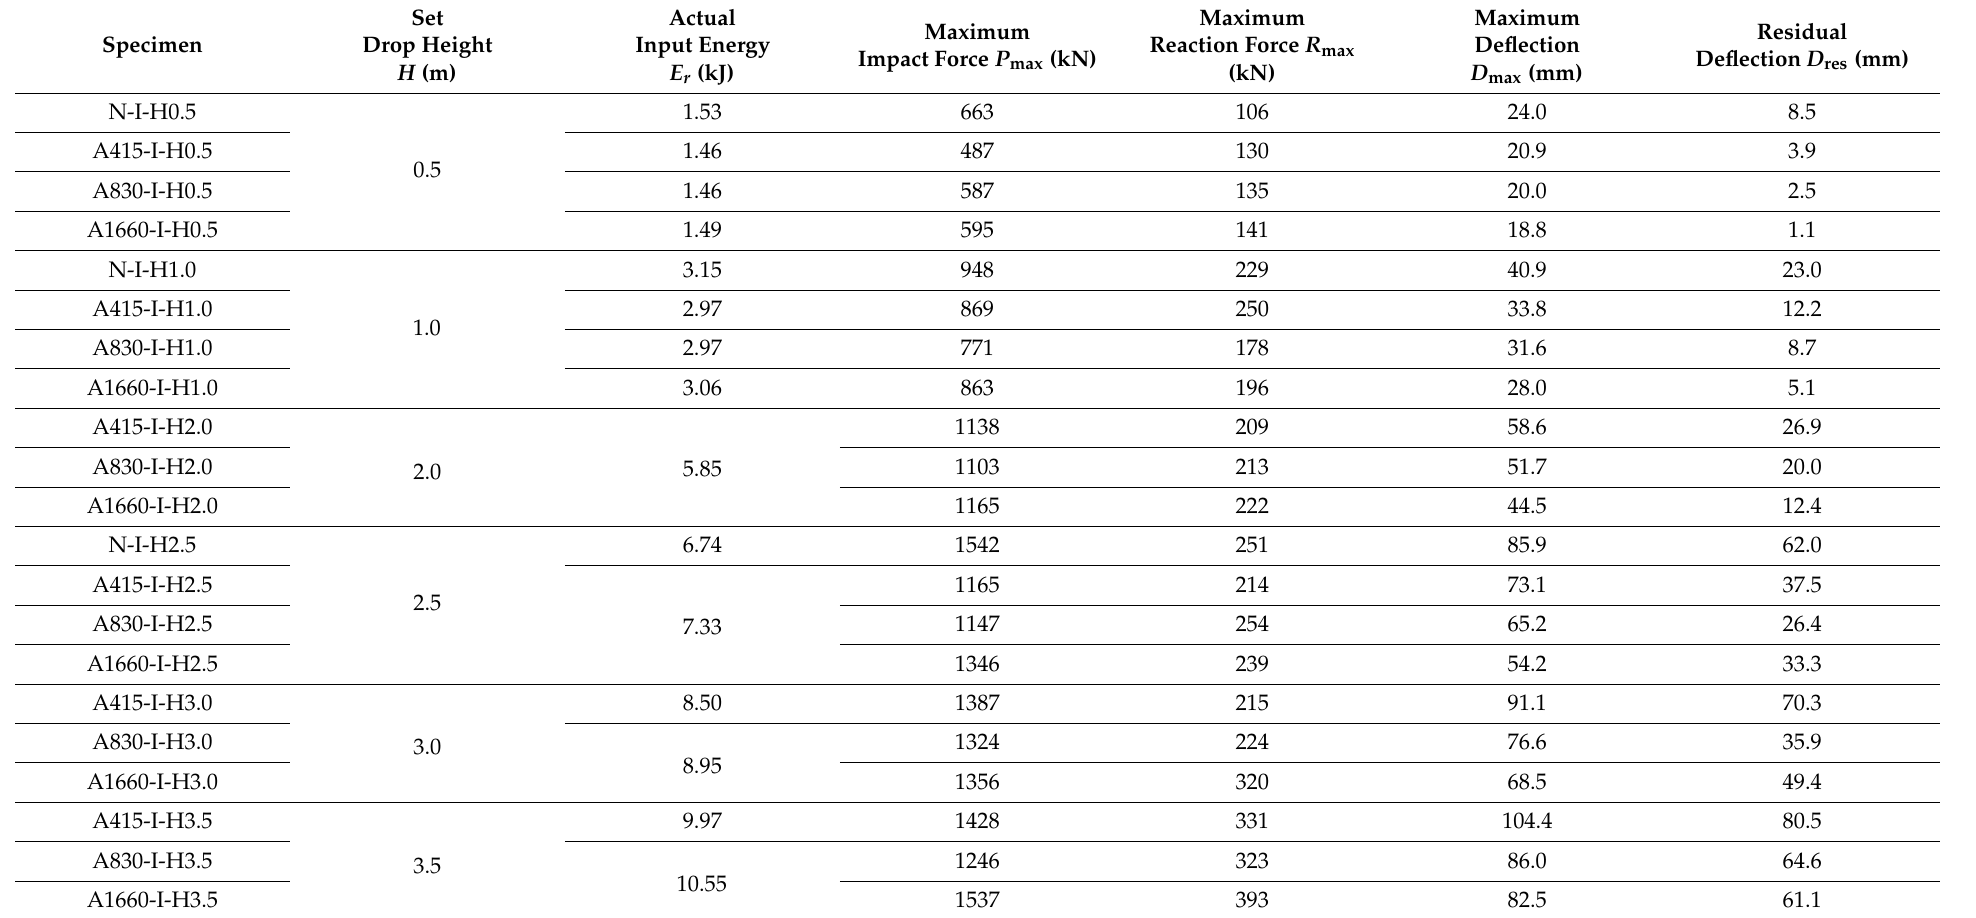
Table 6. Maximum dynamic response values of the RC beams under impact